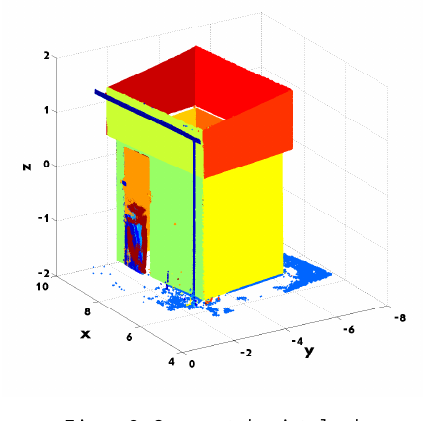
Figure 3: Segmented point